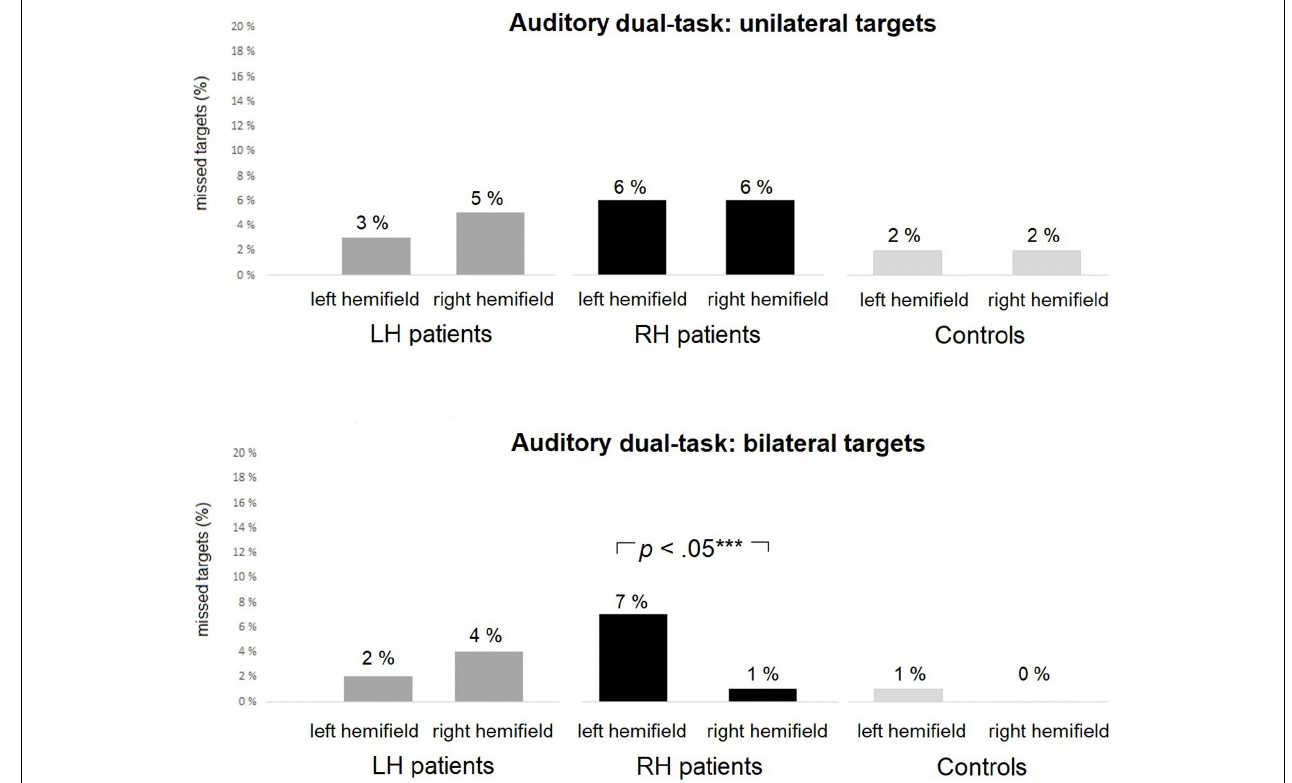
FIGURE 5 | The Auditory dual-task: average percentages of missed targets within each group in unilateral (top panel) and bilateral (bottom panel) trials. RH patients missed significantly more left-sided than right-sided targets in bilateral trials. Asterisks represent effect size (***large